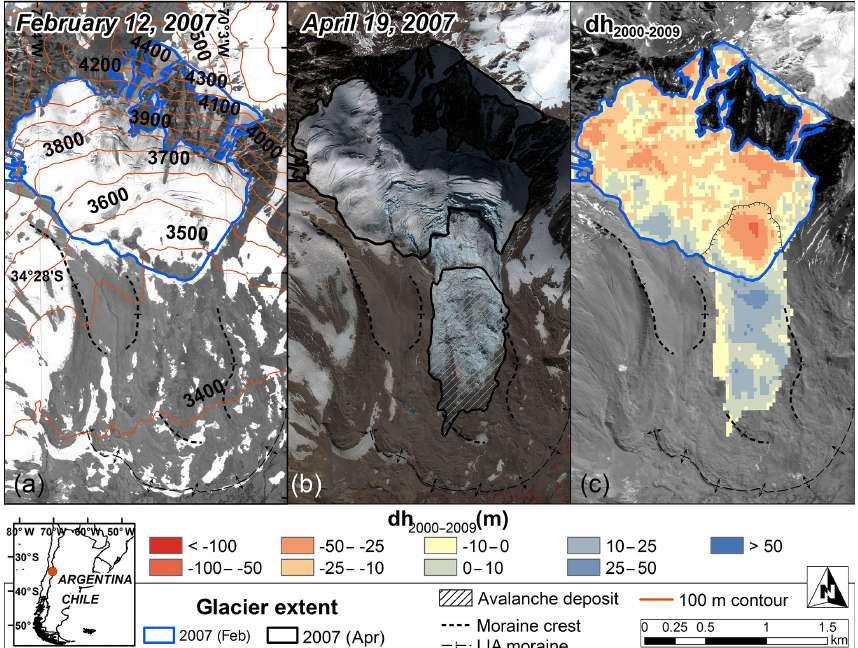
Figure 1. (a) The Leñas Glacier before (SPOT 5, 12 February 2007) and (b) after collapse (QuickBird image – RGB 432 – 19 April 2007). (c) The 2000–2009 elevation differences (background image ALOS PRISM, 31 March 2011). The inset shows the location of the Leñas Glacier in the study